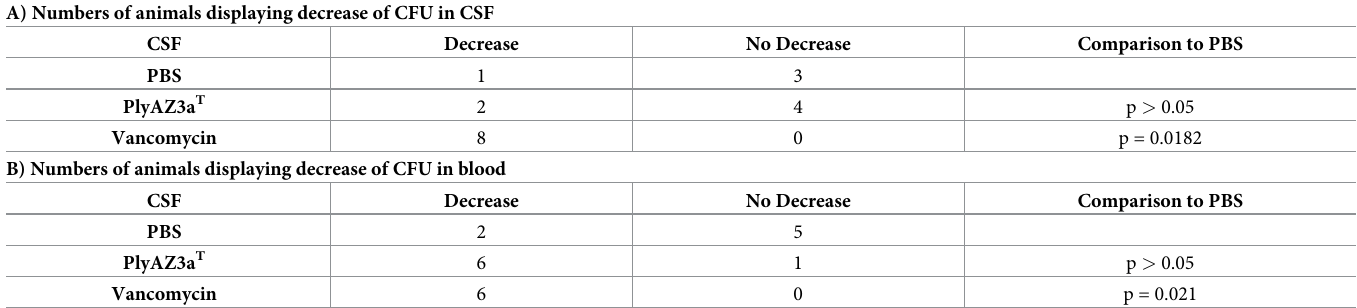
Table 1. Comparison of the decrease of CFU in CSF and blood between treatment groups within the first 6 h after treatment. (A ) Comparison of CFU reduction in CSF and (B) in blood. Statistical significance was determined using Fisher’s exact test. Animals displaying bacterial loads below the limit of detection throughout the exper- iment or missing follow-up sampling were excluded from the